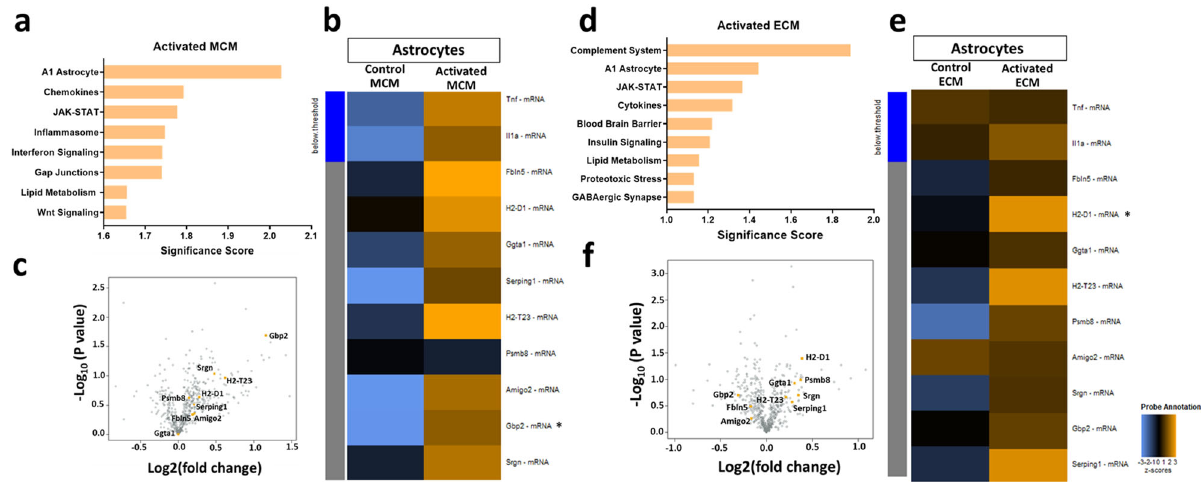
Fig. 3 Endothelial activated astrocytes adopt an A1-like astrocytic pro fi le. a NanoString Gene Set enrichment analysis signi fi cance scores of astrocytes treated with activated MCM vs. control MCM b Unsupervised clustering of global undirected signi fi cance score of A1 astrocytic genes of activated MCM vs. control MCM treated astrocytes c Volcano plots showing directed differentially expressed genes in activated MCM vs. control MCM-treated astrocytes d NanoString Gene Set enrichment analysis signi fi cance scores of astrocytes treated with activated ECM vs. control ECM e Unsupervised clustering of global undirected signi fi cance score of A1 astrocytic genes in activated ECM vs. control ECM treated astrocytes. f Volcano plots showing directed differential expression of activated ECM vs. control ECM treated astrocytes. n = 3. In b and e , asterisks indicate signi fi cant differences, where * P < 0.05 by Mann-Whitney test. Due to the small sample size and exploratory purpose, statistical signi fi cance is reported by raw p values, and is not corrected by